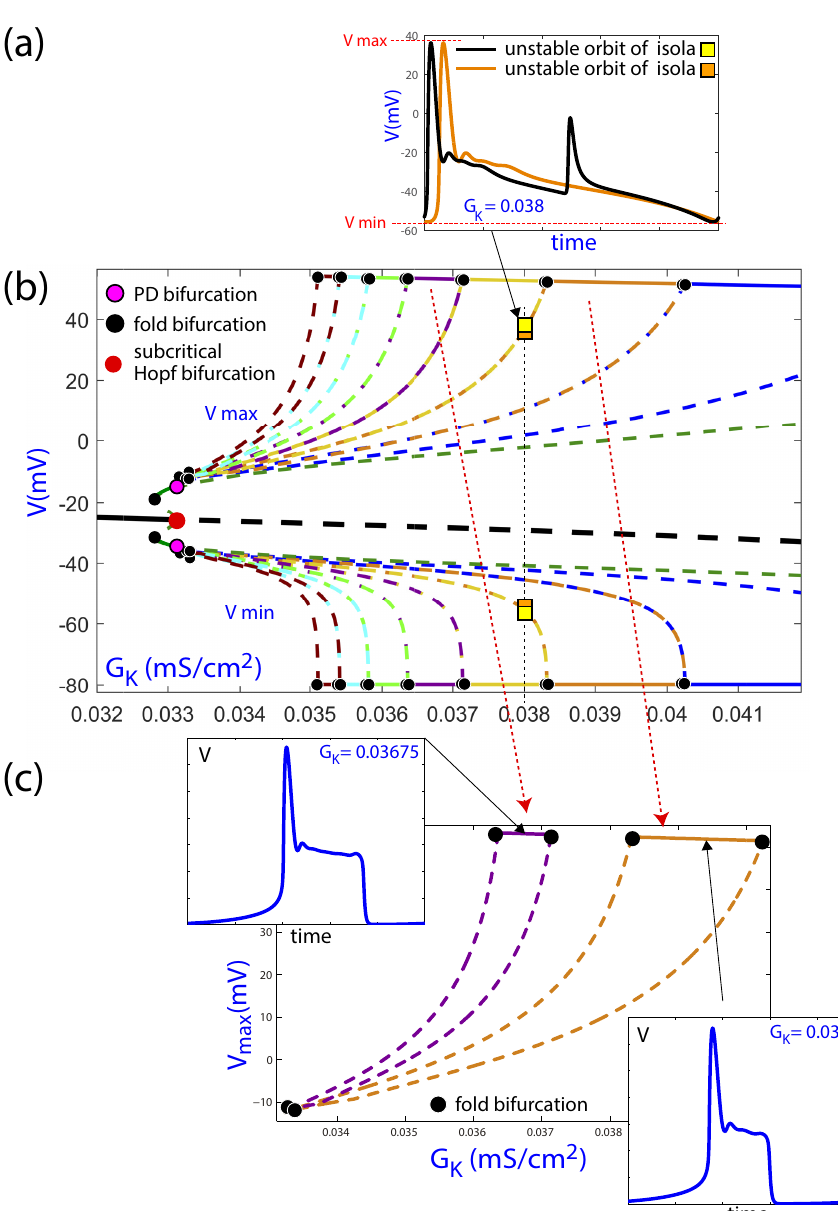
Figure 8. ( b ) Magnification of the bifurcation diagram of Figure 7 using G k as the continuation parameter on the subinterval with isolas. ( a ) Two orbits on two consecutive isolas (orange and yellow ones) for the same value of the parameter G k = 0.038. ( c ) A zoom of the V max component of two isolas. Black thick lines correspond to equilibria, while color lines correspond to limit cycles. Continuous lines represent stable invariants, while discontinuous lines represent unstable invariants. Several bifurcations are pointed (fold and period-doubling bifurcations of limit